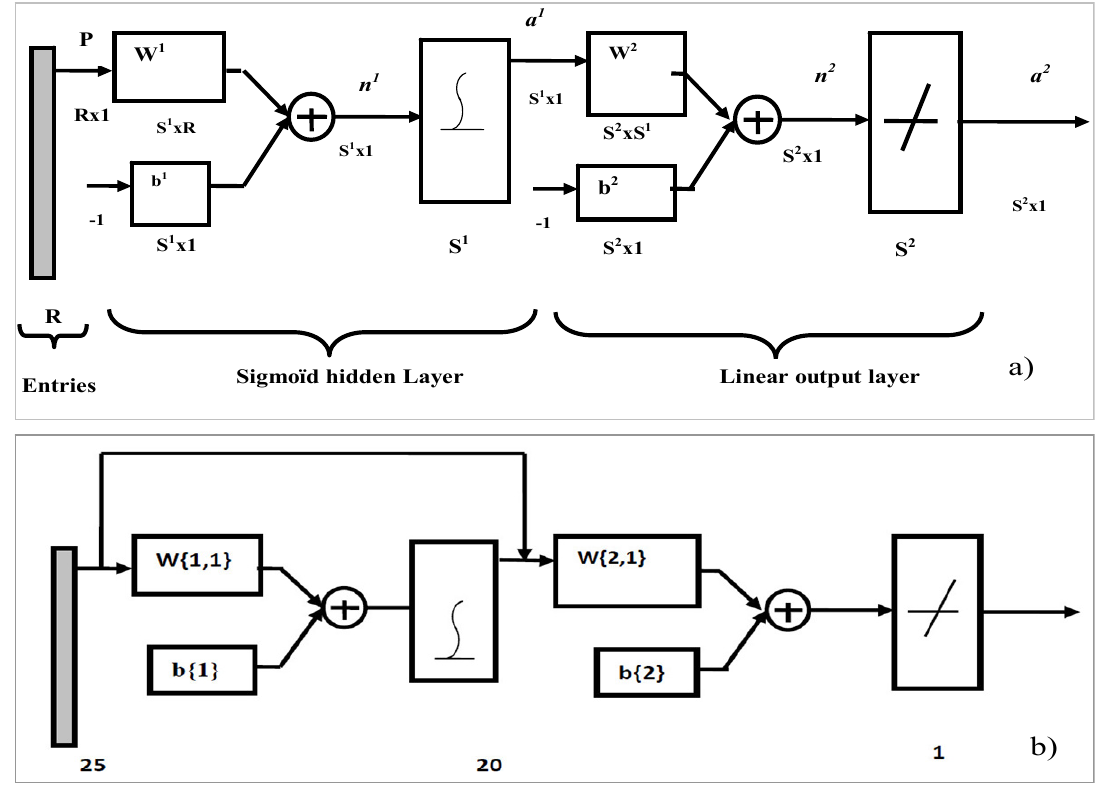
Figure 7. ANN models: ( a ) description of the model; ( b ) the faster CFBP model, which was used for our